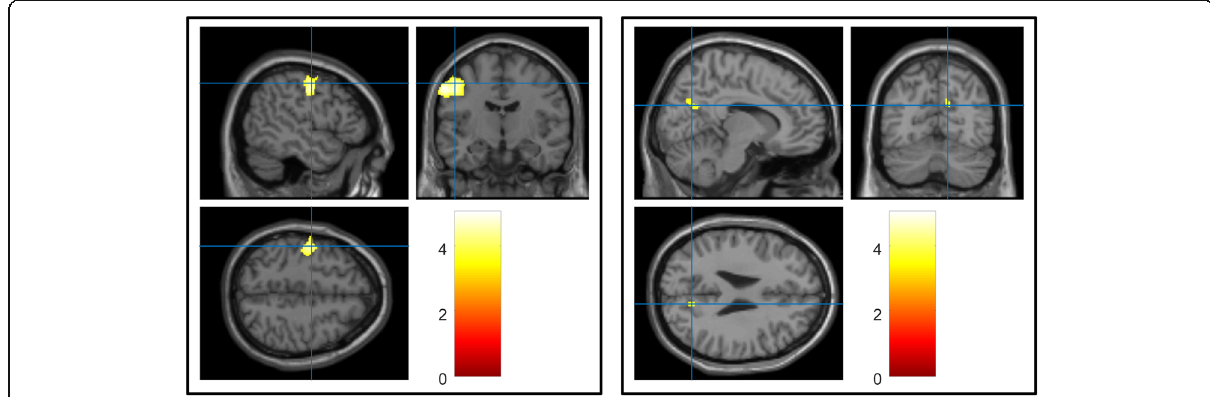
Fig. 2 The significant GM alterations revealed by VBM analyses with the covariate of no interest (TIV) in the a left precentral gyrus and b right precuneus when HG > PG. p value < 0.0005(uncorrected) and extent threshold K = 100